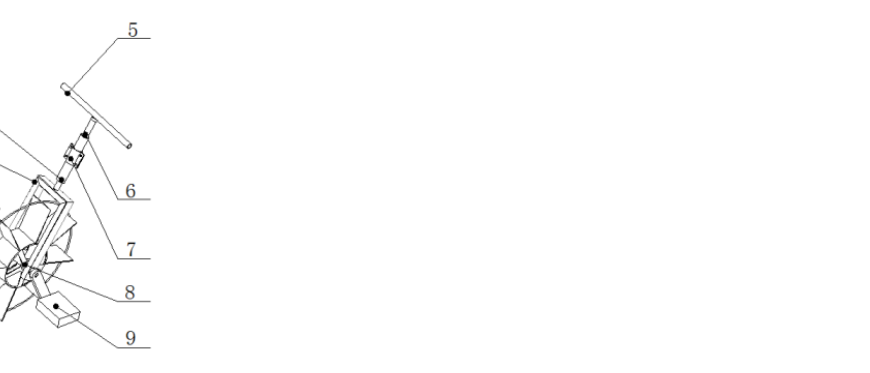
Table 5. Centrifugal pump